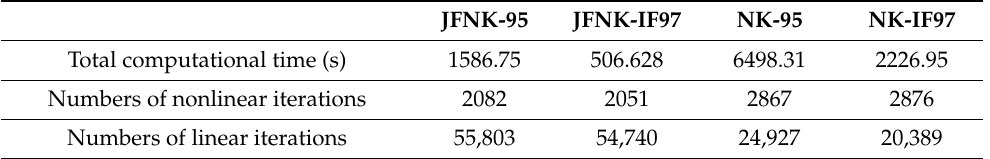
Table 10. Simulation time between different methods of step increase in inlet water temperature.